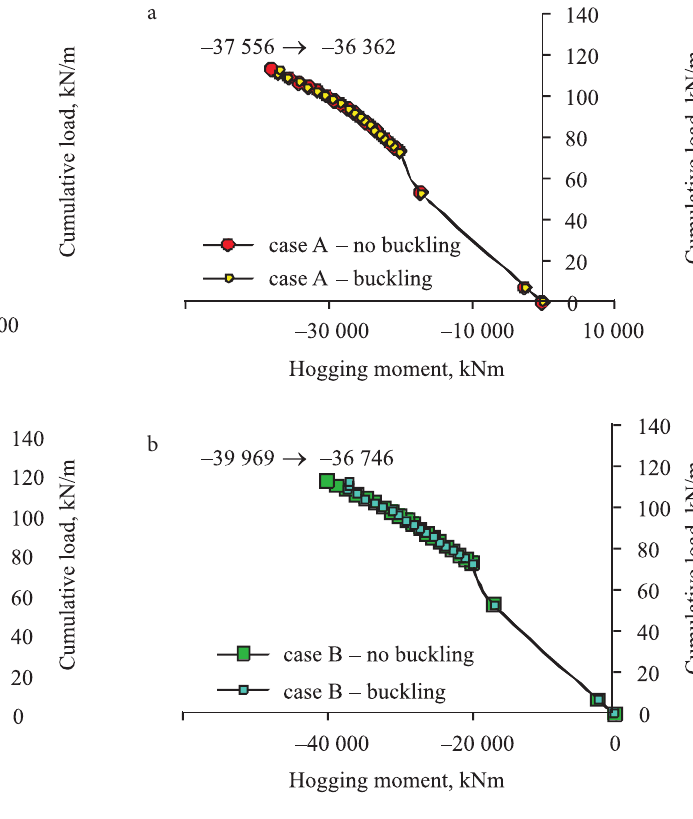
Fig. 15. (θ – M) – bean H5 case A (a) and case B (b)